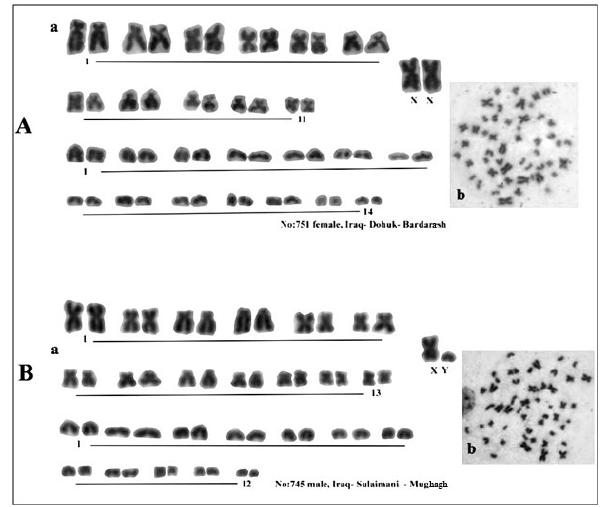
Figure 2. The karyotype Nannospalax ehrenbergi: A. Duhok-Bard- arash population, B. Arbil population. ( a: karyotype, b: metaphase plate).